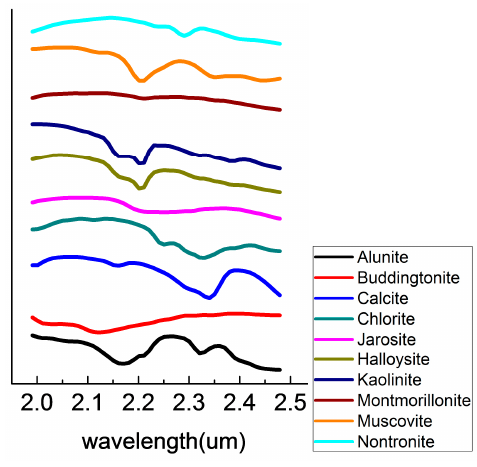
Figure 7. The reference spectra chosen from the USGS library. Table 4. Comparison between the SAD values of N-FINDR, VCA, D-PSO, and MOAQPSO. * means that material cannot be extracted.